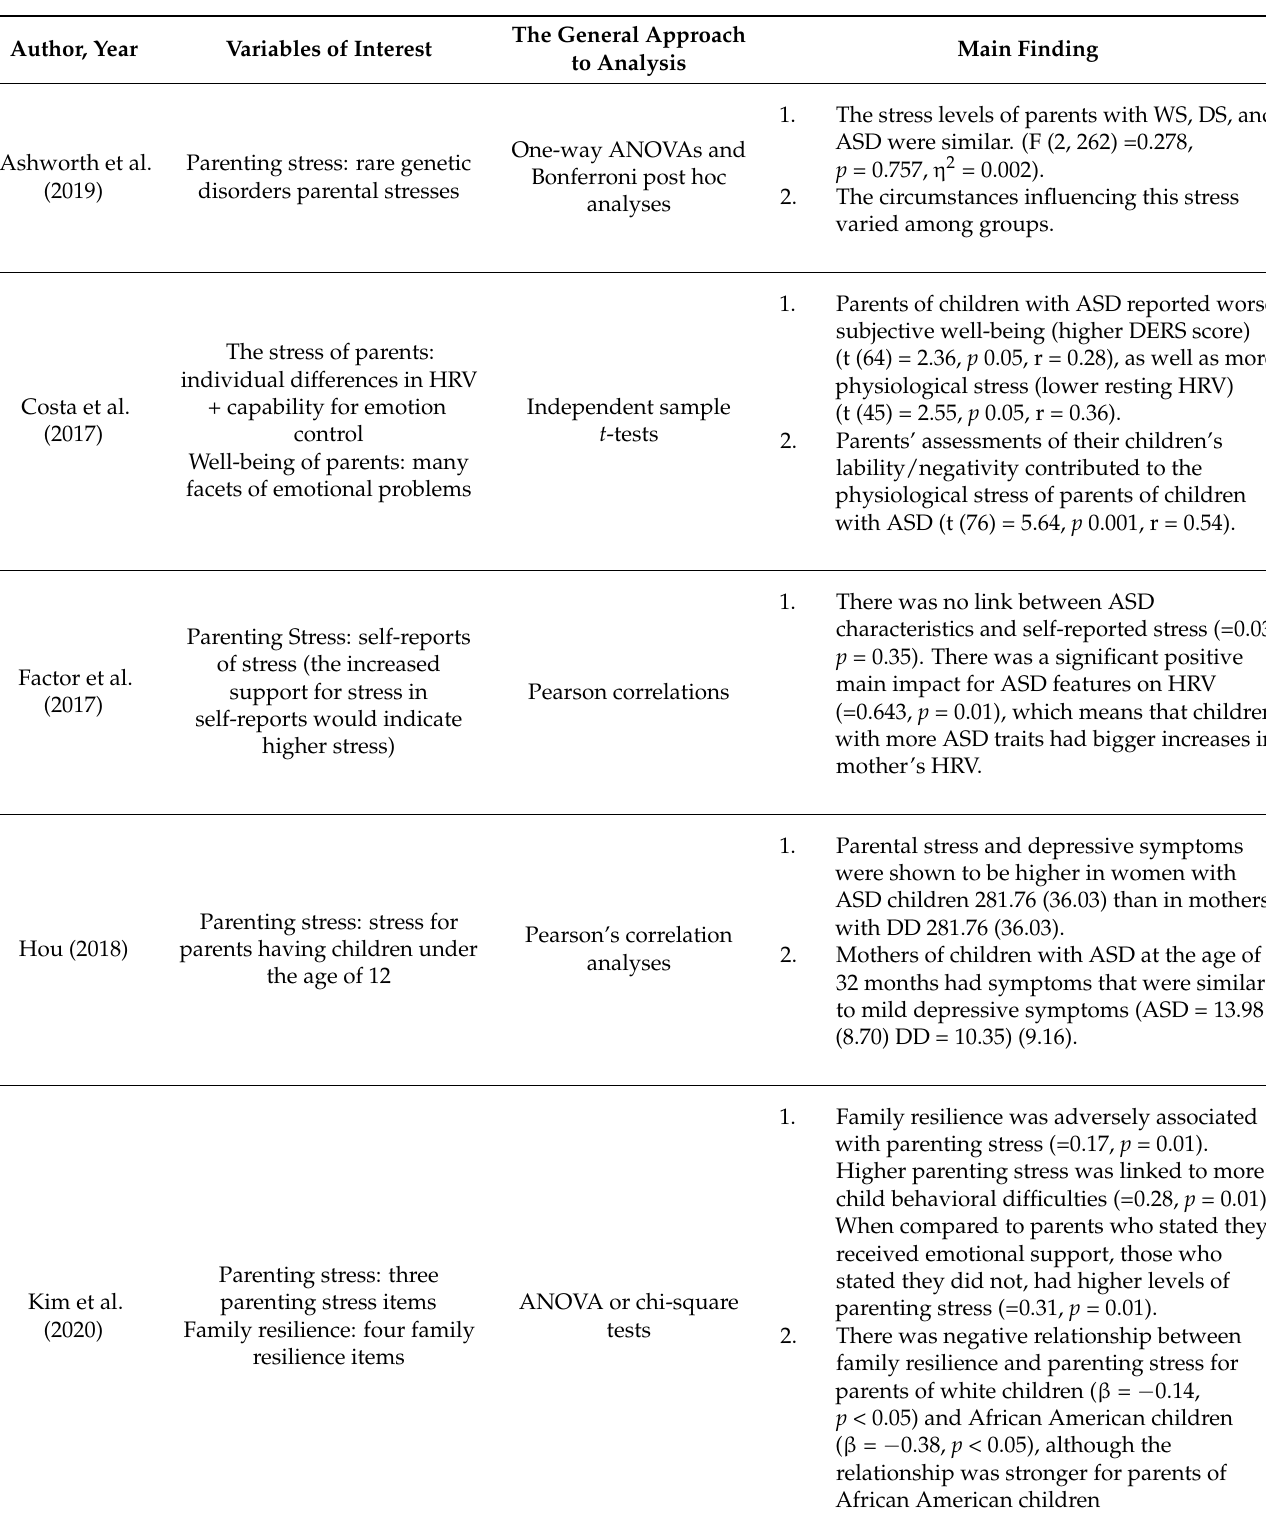
Table 3. Interest variable, analytic technique, and key findings of the studies